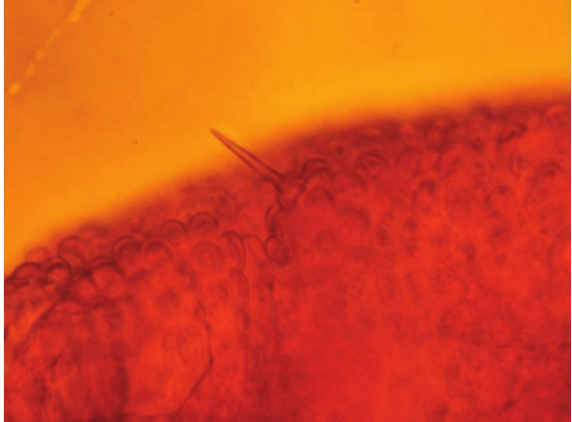
Figure 24: The terminal papillae of the posterior abdominal seg- ments are stout socketed bristles and appear to be sensilla chaetica.